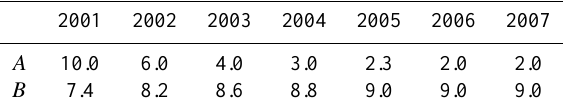
Table 1. This table shows the variations of the coefficients A and B , as defined in Eq. (1), over the waning phase of solar cycle 23. These values are taken from Pedersen et al. (2008).